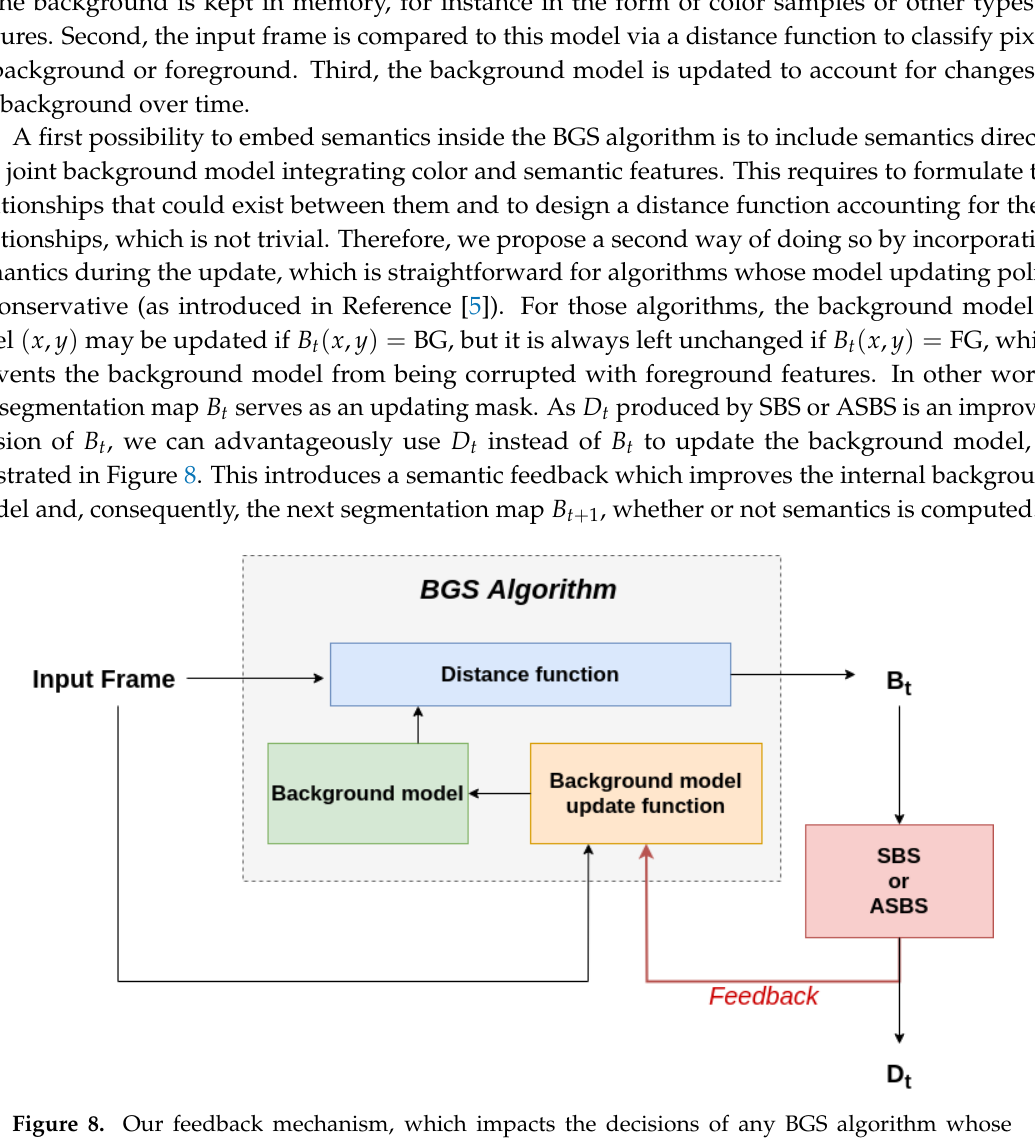
Figure 8. Our feedback mechanism, which impacts the decisions of any BGS algorithm whose model update is conservative, consists to replace the BG/FG segmentation of the BGS algorithm by the final segmentation map improved by semantics (either by SBS or ASBS) to update the internal background